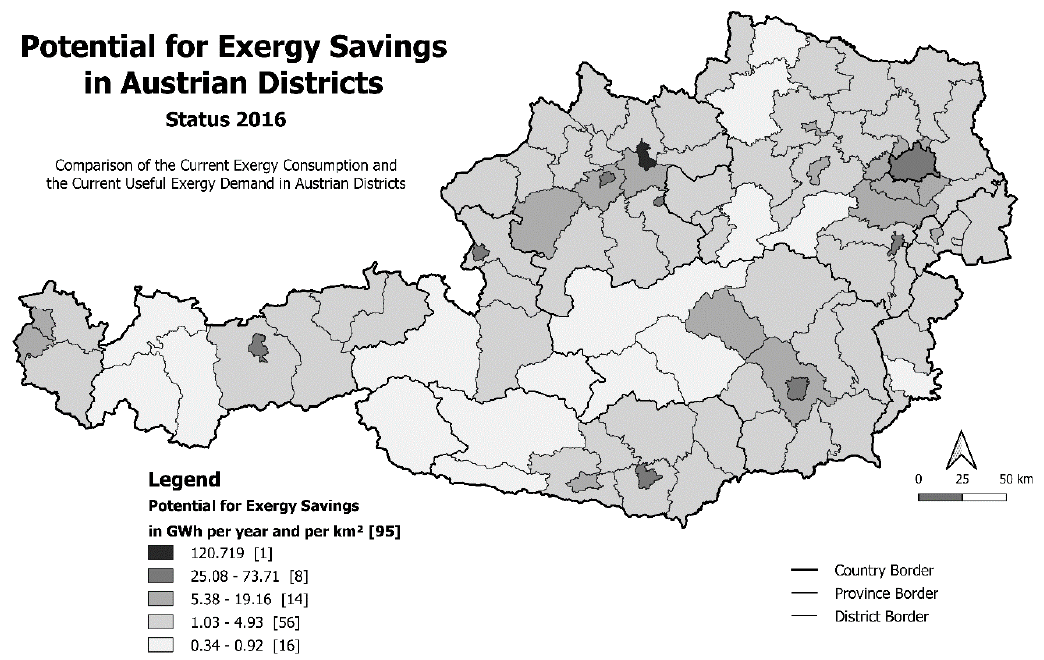
Figure 13. The potential for exergy savings per district can be calculated by the current exergy consumption and the current useful exergy demand. One can see that the districts with a high current exergy consumption (Figure 7) also have a high potential for exergy savings (map source: Statistics Austria - data.statistik.gv.at).